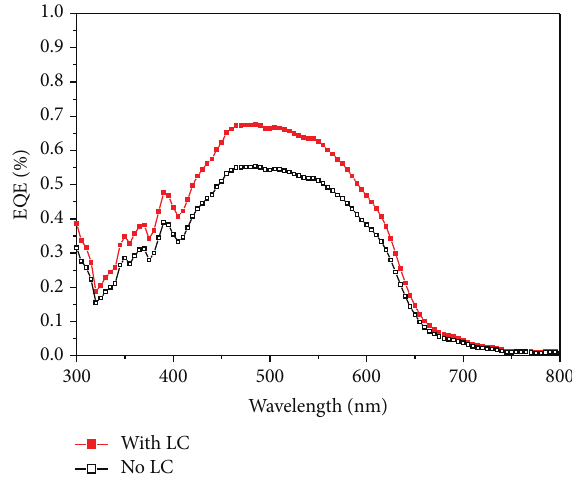
Figure 5: The EQE spectra for semitransparent PSCs both with and without the LC reflector; the active layers were both 100 nm